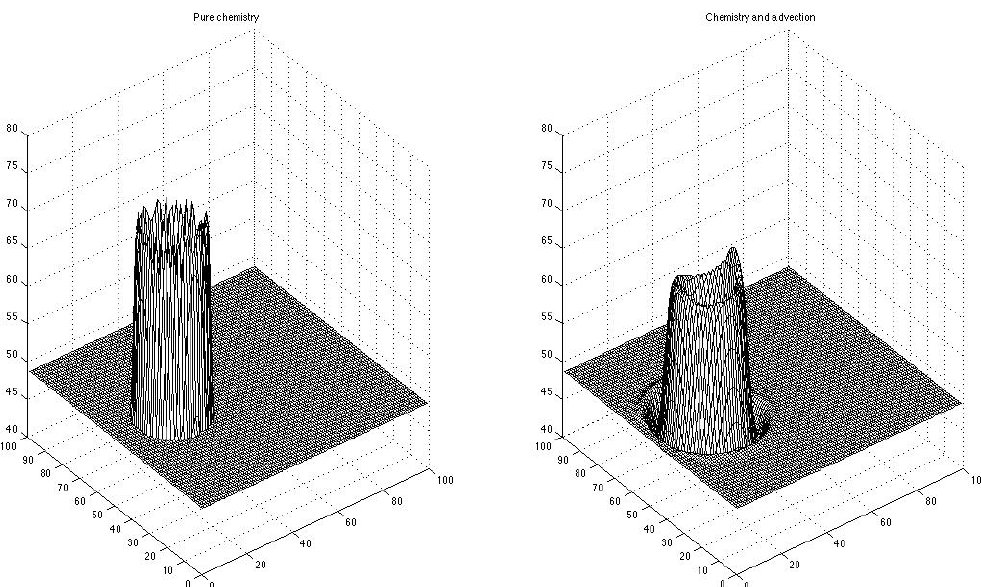
Fig. 6. Rotation test for LMC cascade using the rotating cone for O 3 with urban conditions and resolution 1 1, with 1t = 90s, 1x = 1 . 0, and C = 0 . 327. The results are given for pure chemistry (left) and combined chemistry and advection (right). The minimum and maximum values for the respective plots are: Left: minimum=48.55, maximum=64.58. Right: minimum=44.41, maximum=69.15.